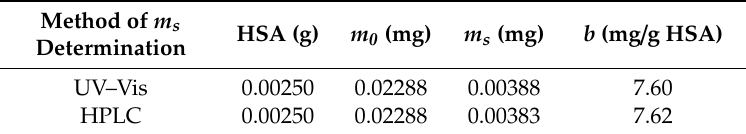
Table 3. Results of free HSA interaction with KP solution detected by UV–Vis spectroscopy and HPLC analysis.